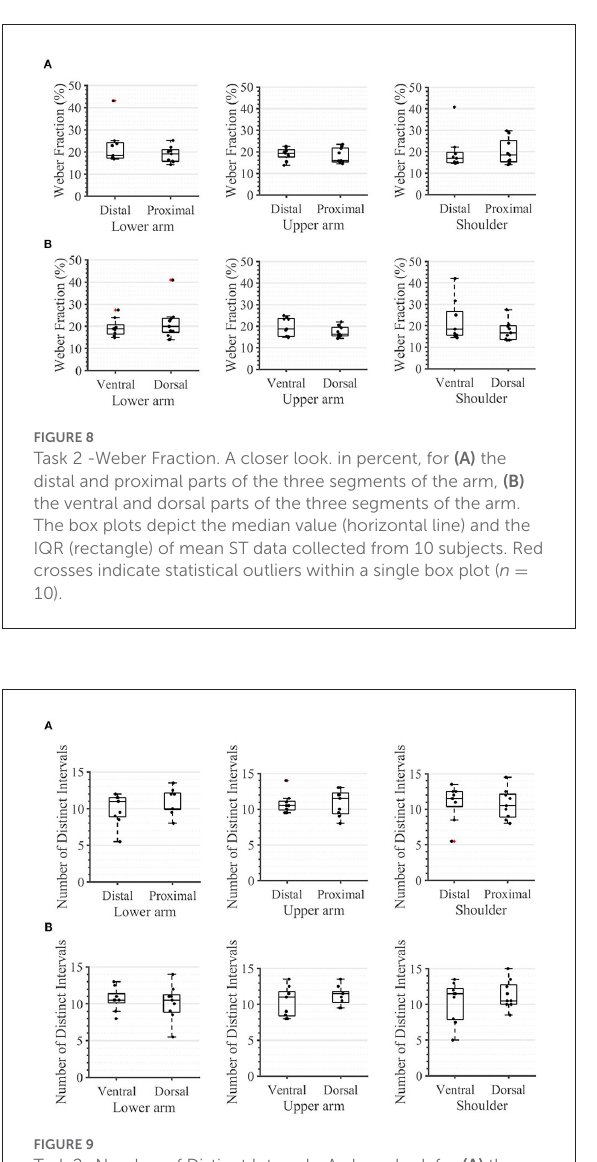
FIGURE9 Task 2 -Number of Distinct Intervals. A closer look for (A) the distal and proximal parts of the three segments of the arm, (B) the ventral and dorsal parts of the three segments of the arm. The box plots depict the median value (horizontal line) and the IQR (rectangle) of mean ST data collected from ten subjects. Red crosses indicate statistical outliers within a single box plot ( n = 10).